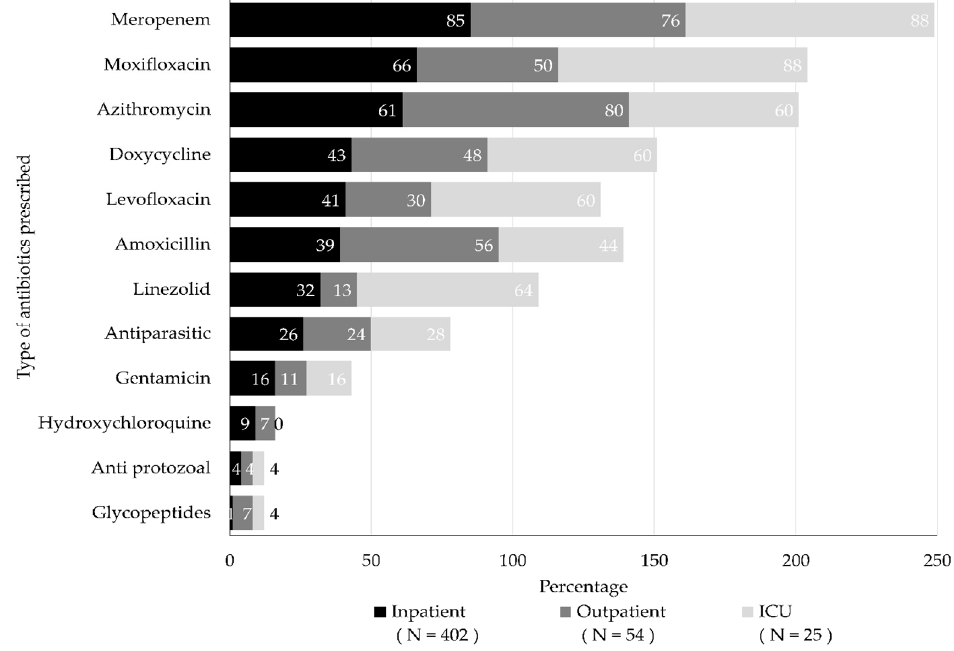
Figure 3. Type of antibiotics prescribed to CVOID-19 patients, regardless of illness severity, based on duty ward of the study physicians.